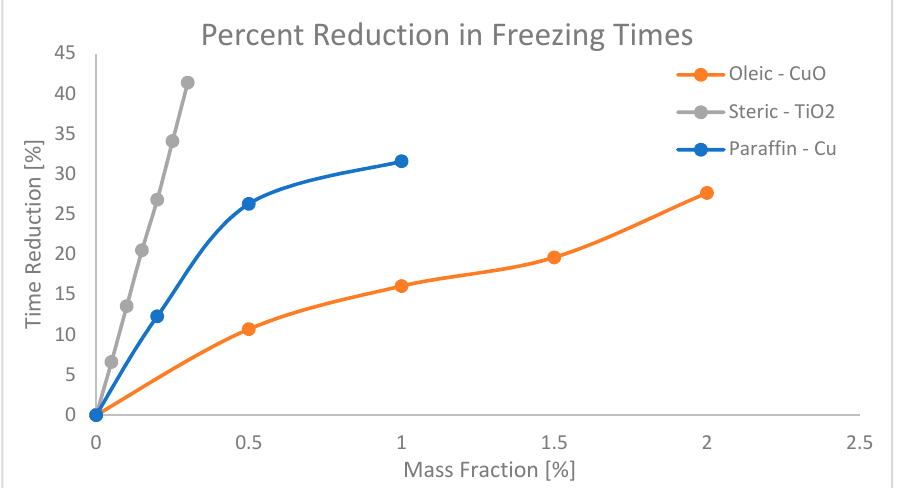
Figure 12. Percent reductions in freezing times of paraffin, oleic and steric acids from references [27,51,52].